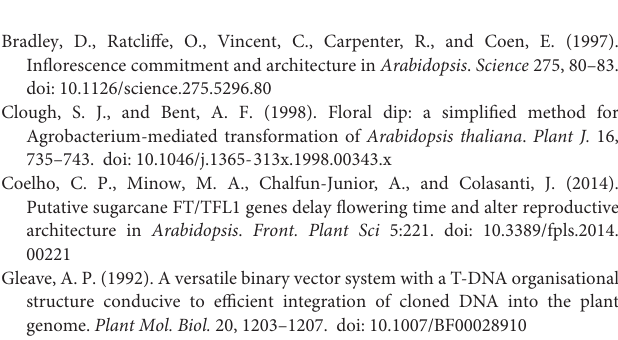
Supplementary Table 4 | Flowering times of soybean landraces determined by the number of days to flowering. Supplementary Table 5 | Primers used for exon swapping. Supplementary Table 6 | Primers used for amino acid